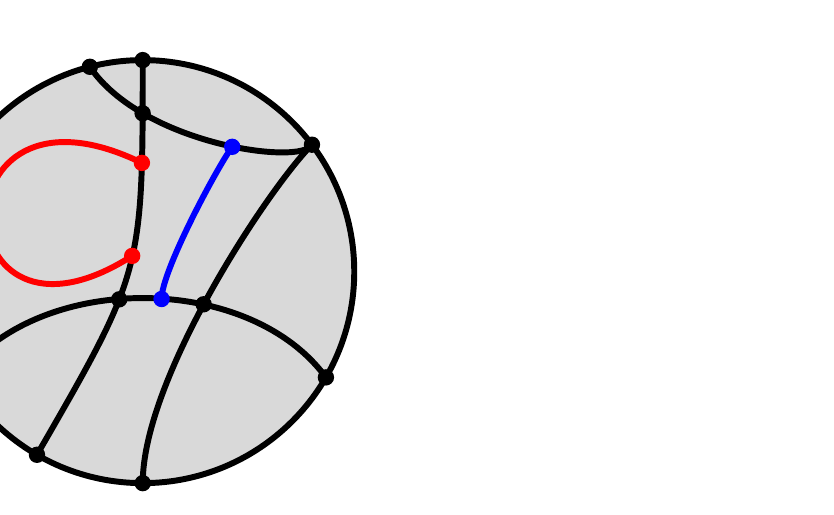
Figure 3. The blue edge starts and ends at the same new vertex, while the red one starts from an old vertex and ends in a new one.